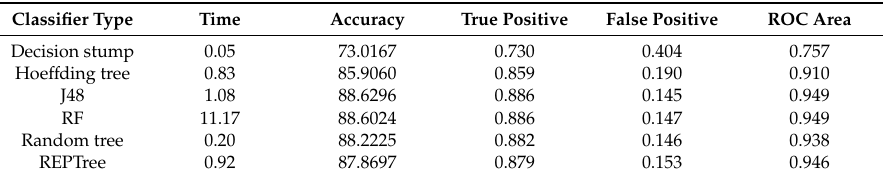
Table 1. A comparison of classification algorithms.